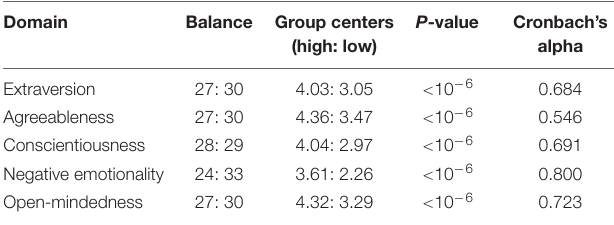
TABLE 1 | Labeling results and Cronbach’s alpha of all BFI-2-S domains.